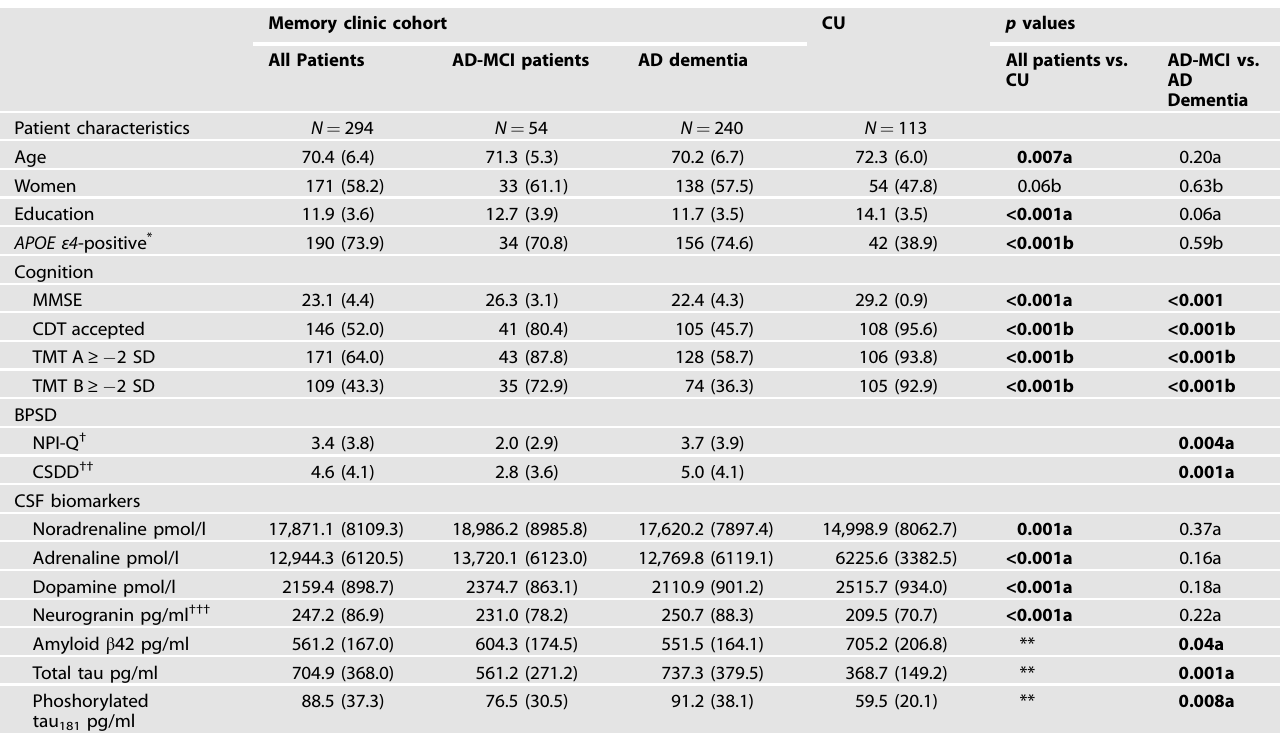
Table 1. Characteristics of the whole